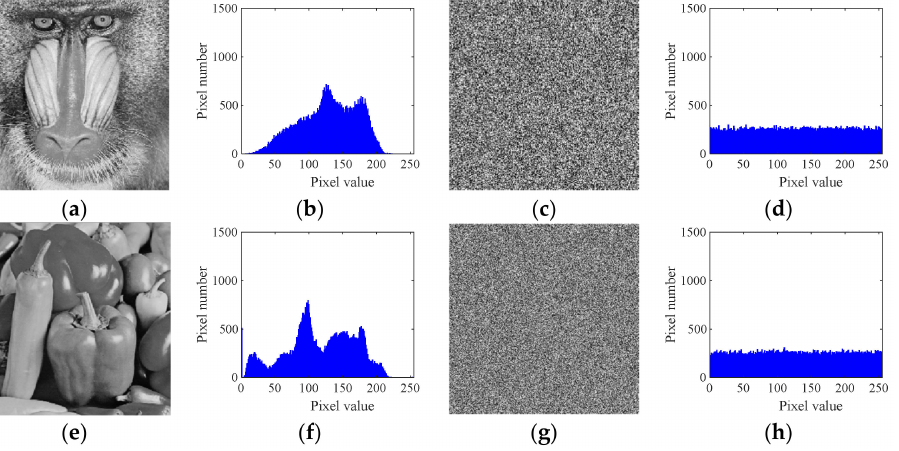
Figure 9. Plaintext/encrypted images and their histograms. ( a ) Plaintext image Baboon. ( b ) His- togram of ( a ). ( c ) Encrypted image Baboon. ( d ) Histogram of ( c ). ( e ) Plaintext image Peppers. ( f ) Histogram ( e ). ( g ) Encrypted image Peppers. ( h ) Histogram of ( g ).